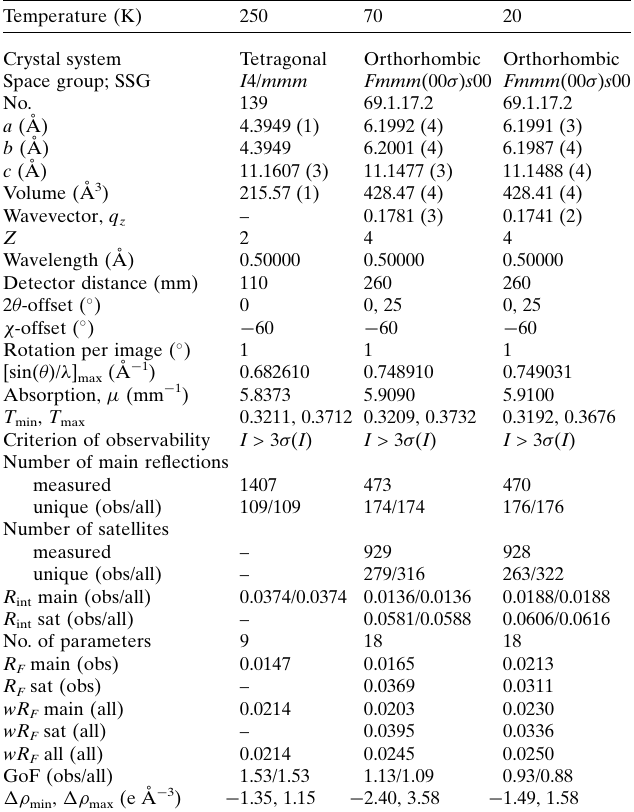
Table 1 Crystallographic data of crystal A of EuAl 4 at 250, 70 and 20 K. Refinement method used: least-squares on F . The superspace group (SSG; No.) is given according to Stokes et al. (2011). Temperature (K)